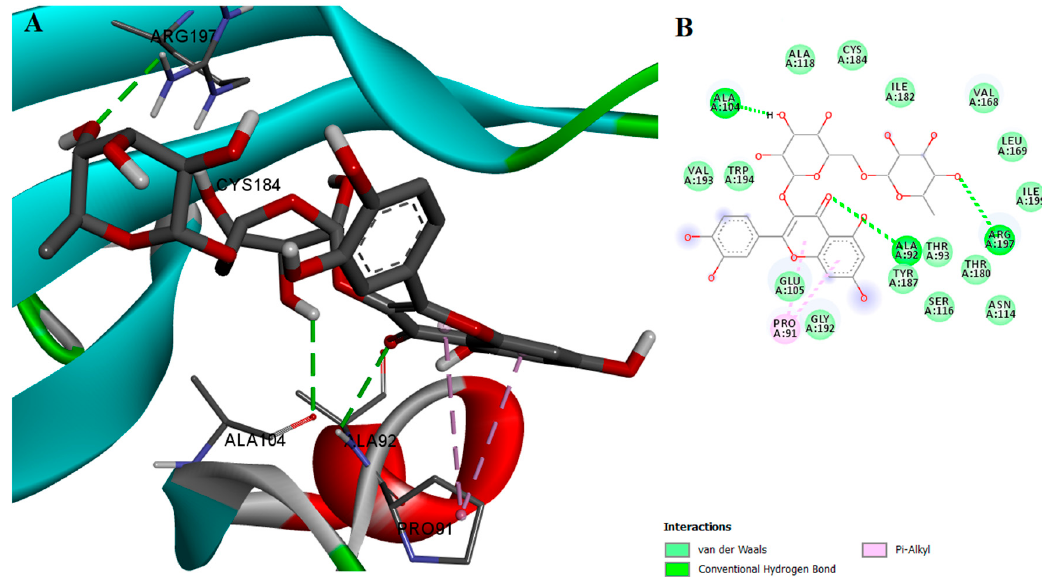
Figure 6. ( A ) Docked conformation and interactions of the rutin-SrtA complex; ( B ) 2D diagram of the predicted interactions; backbone of the protein is colored in grey, β -helices in turquoise, α -helices in red and loops in green. Ligand-protein interactions are colored depending on their type: conventional hydrogen bonds are colored in green, π - σ and π -alkyl interactions are colored in purple and light purple, respectively.